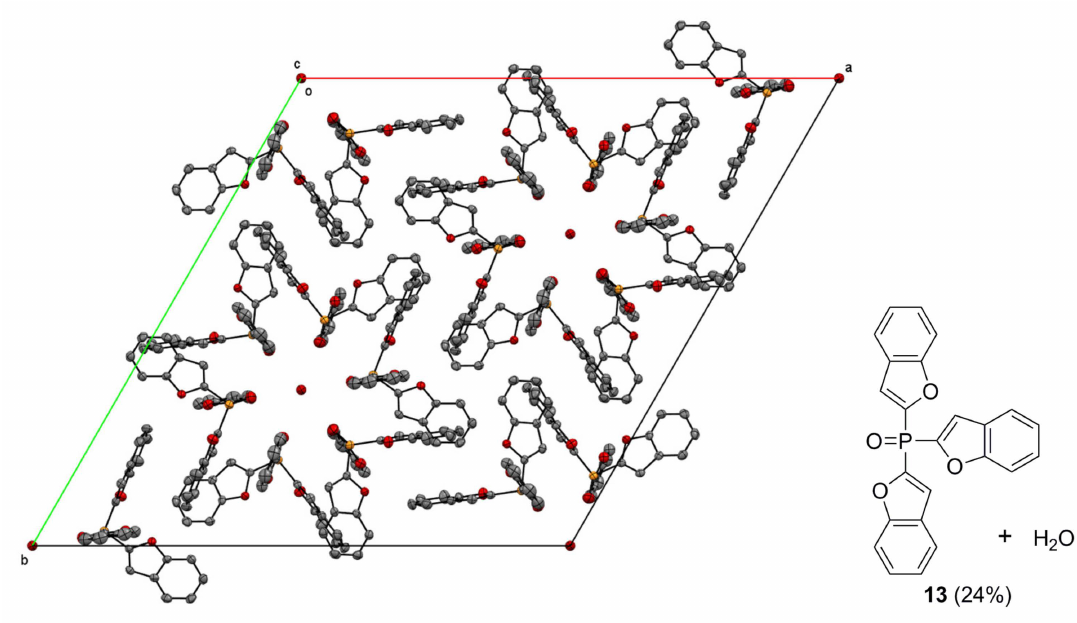
Figure 2. Crystal packing of the complex of tri-2-benzofuryl phosphine oxide 13. The displacement ellipsoids are drawn at the 50% probability level. Hydrogen atoms are omitted for